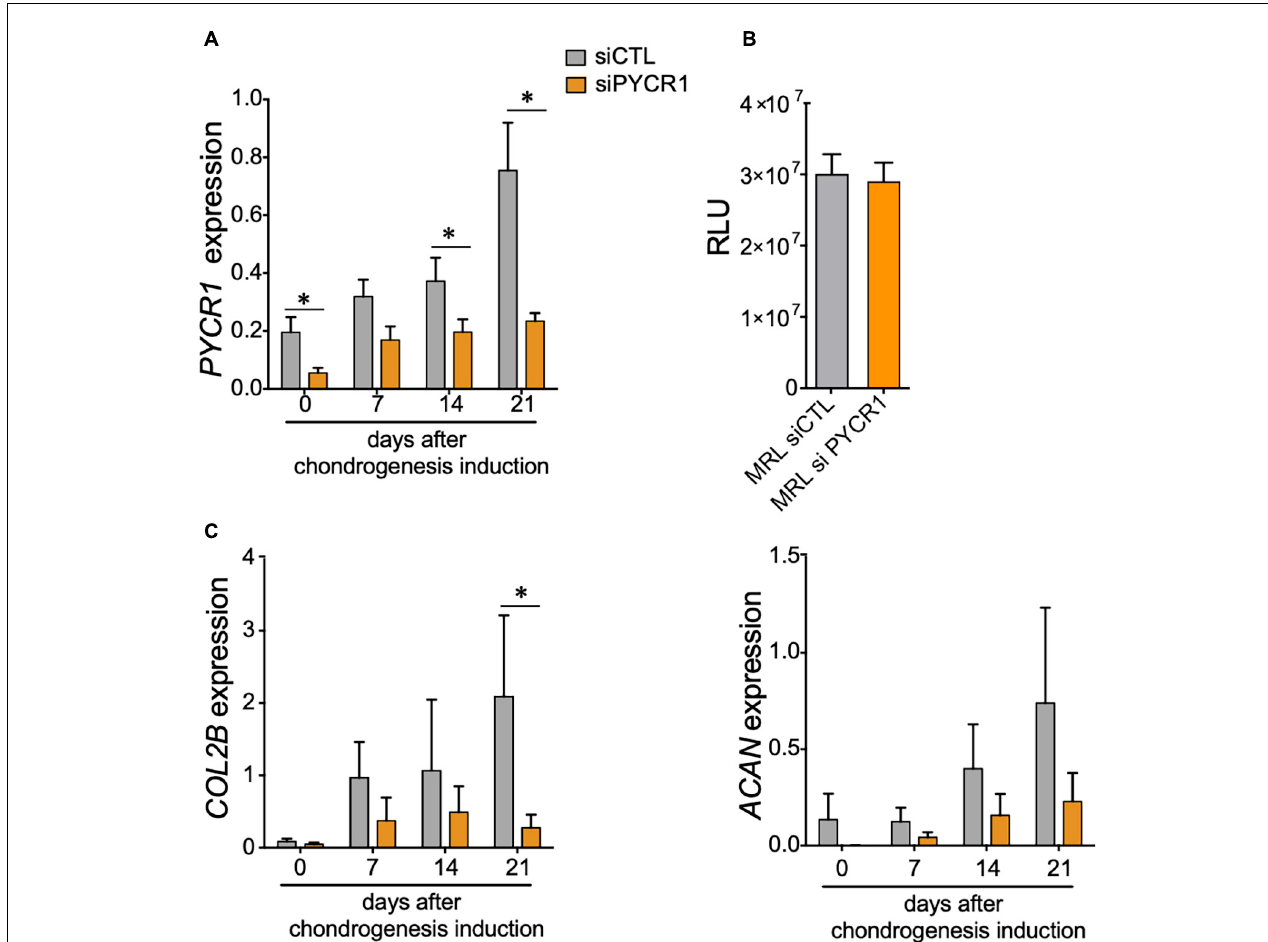
FIGURE 2 | Pycr1 is required for the chondrogenic potential of MRL MSCs. (A) Pycr1 mRNA expression level in MRL MSCs transfected with either a control siRNA (siCTL) or a siRNA against Pycr1 (siPYCR1) at different time points of the chondrogenic differentiation induced in pellets by TGF β 3. (B) Proliferation rate of MRL MSCs transfected with either a control siRNA (siCTL) or a siRNA against Pycr1 (siPYCR1). (C) mRNA expression levels of chondrocyte markers, Col2B and Acan , in MRL MSCs transfected with either siCTL or siPYCR1 at different time points of the chondrogenic differentiation induced in pellets by TGF β 3. Results represent the mean ± SEM of three independent experiments. Statistics: Mann–Whitney test, two-tailed. p -Values < 0.05 ( ∗ ). MRL, Murphy Roths Large; MSCs, mesenchymal stem cells; siRNA, small interfering